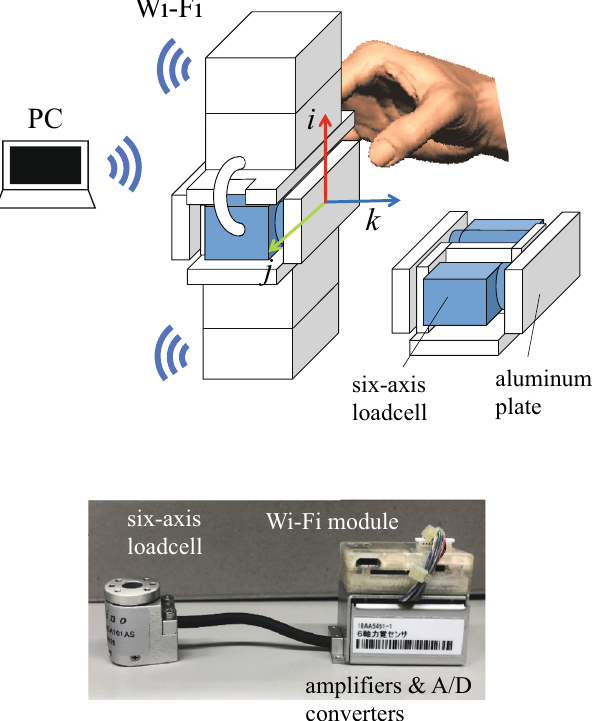
Figure 3. Custom-made wireless fingertip force-sensing device. The device consisted of two six-axis load cells, amplifiers, A/D converters, and Wi-Fi modules with batteries. An aluminum plate (20 mm × 49 mm) was attached to each load cell so that the forces applied by the thumb and index fingers could be measured independently. The amplifiers, A/D converters, and Wi-Fi modules with batteries were attached to the top and bottom of the load cell housing. The vectors i,j,k represent the sensor-fixed local coordinate system.